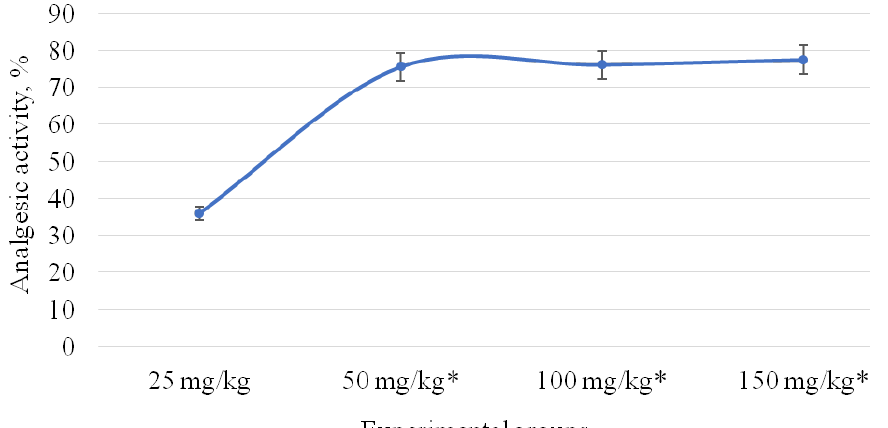
Fig. 2. The curve of changes in the analgesic activity of different doses of the paracetamol and N-acetyl-D-glucosamine combination in a ratio of 4:1 : * – p<0.05 compared to group treated with PAR/NAG combination (4:1) at a dose of 25